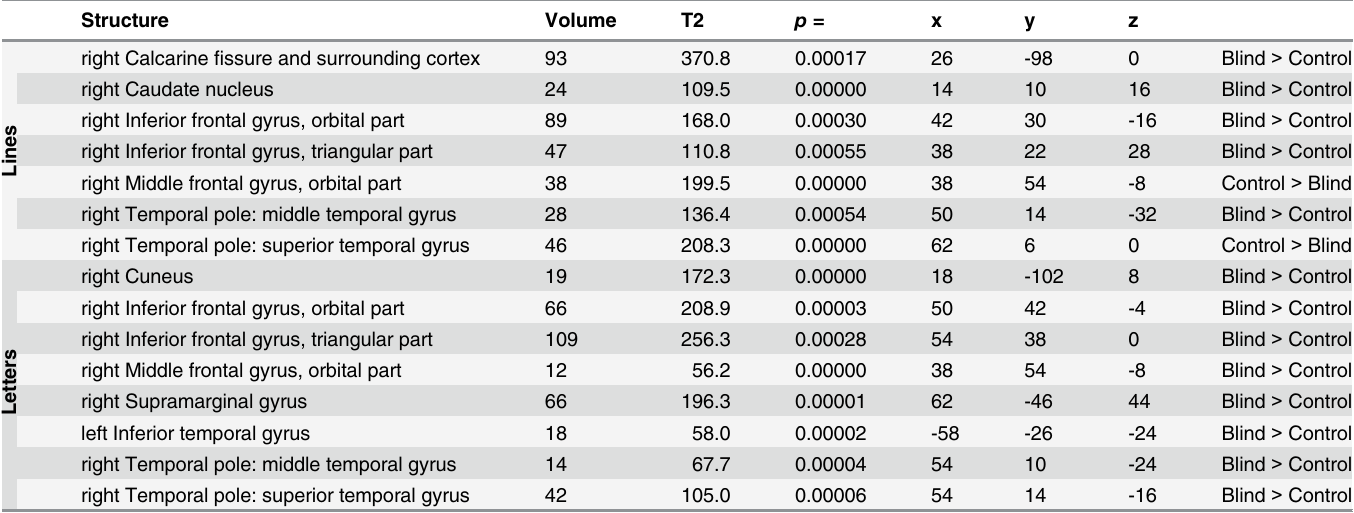
Table 4. Summary of significant differences between children with blindess and seeing controls at the maximal intensity projection areas for P100 during line or letter presentation (non-target trials). For each specific localization, independent Hotelling T2 significant differences between seeing con- trols and blind groups are provided. AAL = X, Y, Z = co-ordinates from MNI in three spatial axes. p < .05. Structure